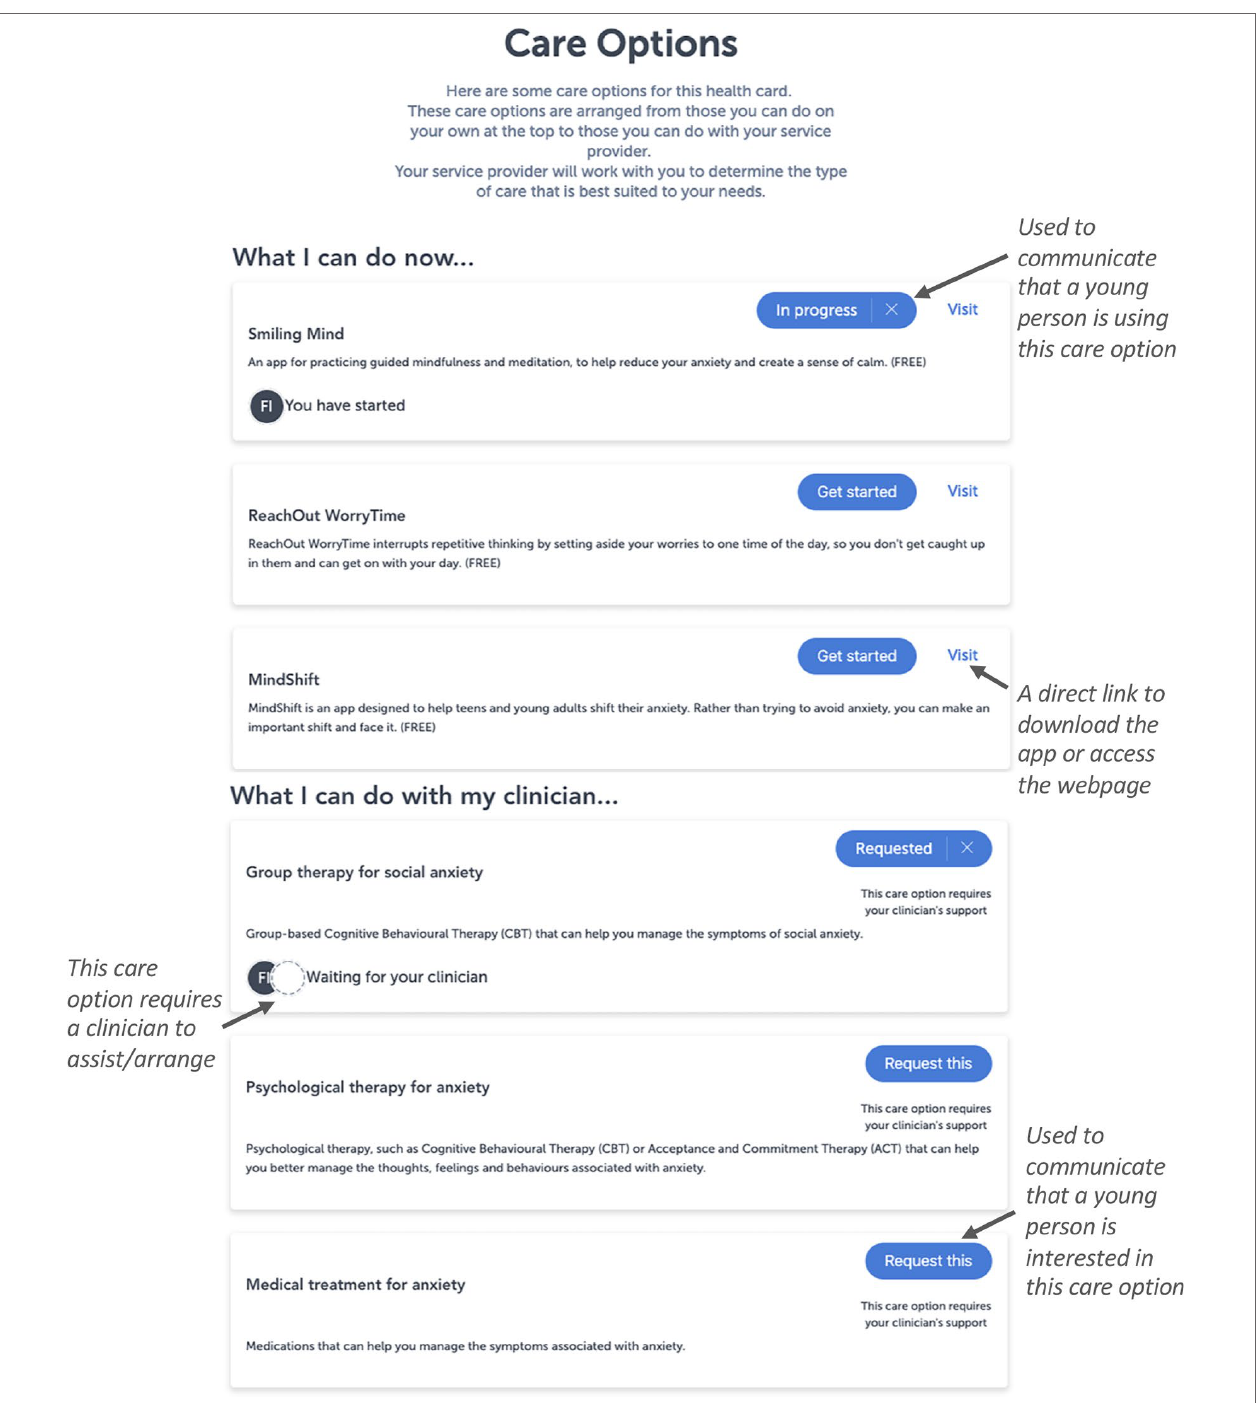
FIGURE 2 | The more detailed view of the dashboard of results, which facilitates shared-care planning and the management of mental ill-health. The figure presents the care options that are available for this particular domain and shows how the blue buttons can be used to facilitate shared decision-making. These care options are customized according the health service using the Platform, so that it accurately reflects their clinical offering. Each care option is accompanied by a title, a description, an action button, and a status icon on the bottom left. Specific actions can be performed for these care options using the buttons on the right of each care option. In this example, the circle with an “FI” on the “smiling mind” care option is used to indicate that this young person has started to use the app to address their anxiety. The circle with an “FI” and dotted circle on the “group therapy for social anxiety” care option is used to indicate that the young person is interested in this intervention and would like to speak to their clinician about it. Please note that the image presented here displays the Platform as it exists at the date of this publication, and is subject to further development and